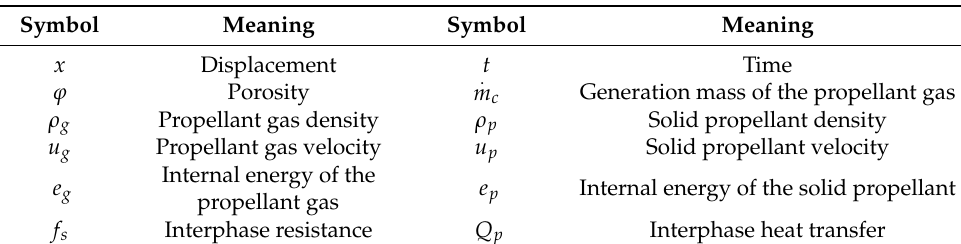
Table 1. The symbol meanings in the model of the launch load.